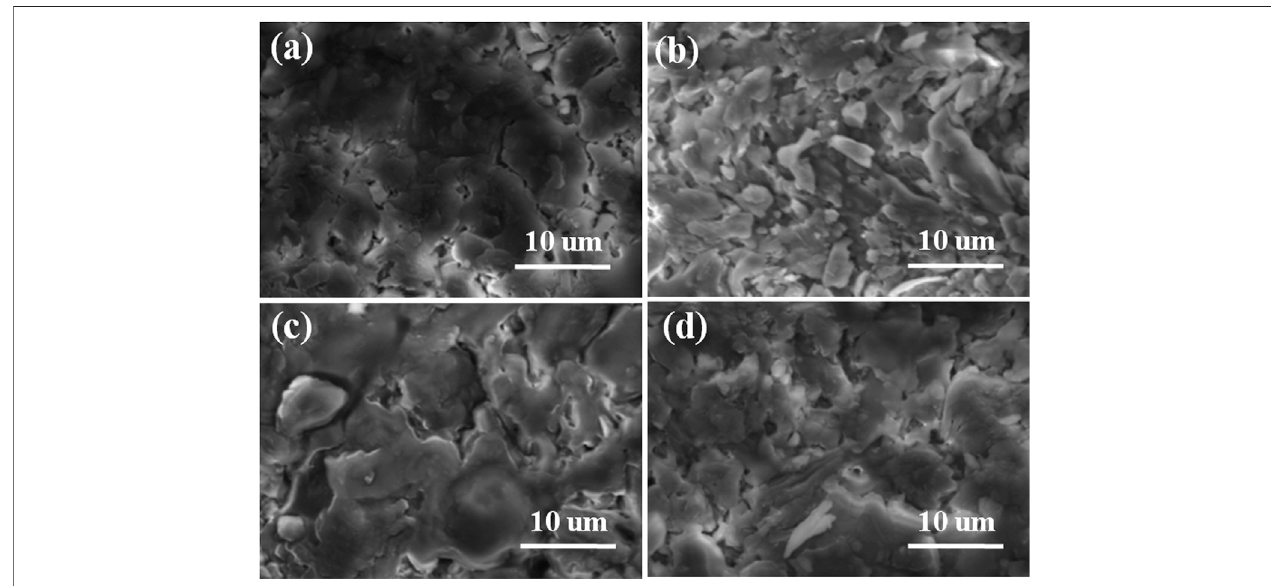
FIGURE 3 | SEM images of (A) KCC-0, (B) KCC-1, (C) KCC-2, (D)